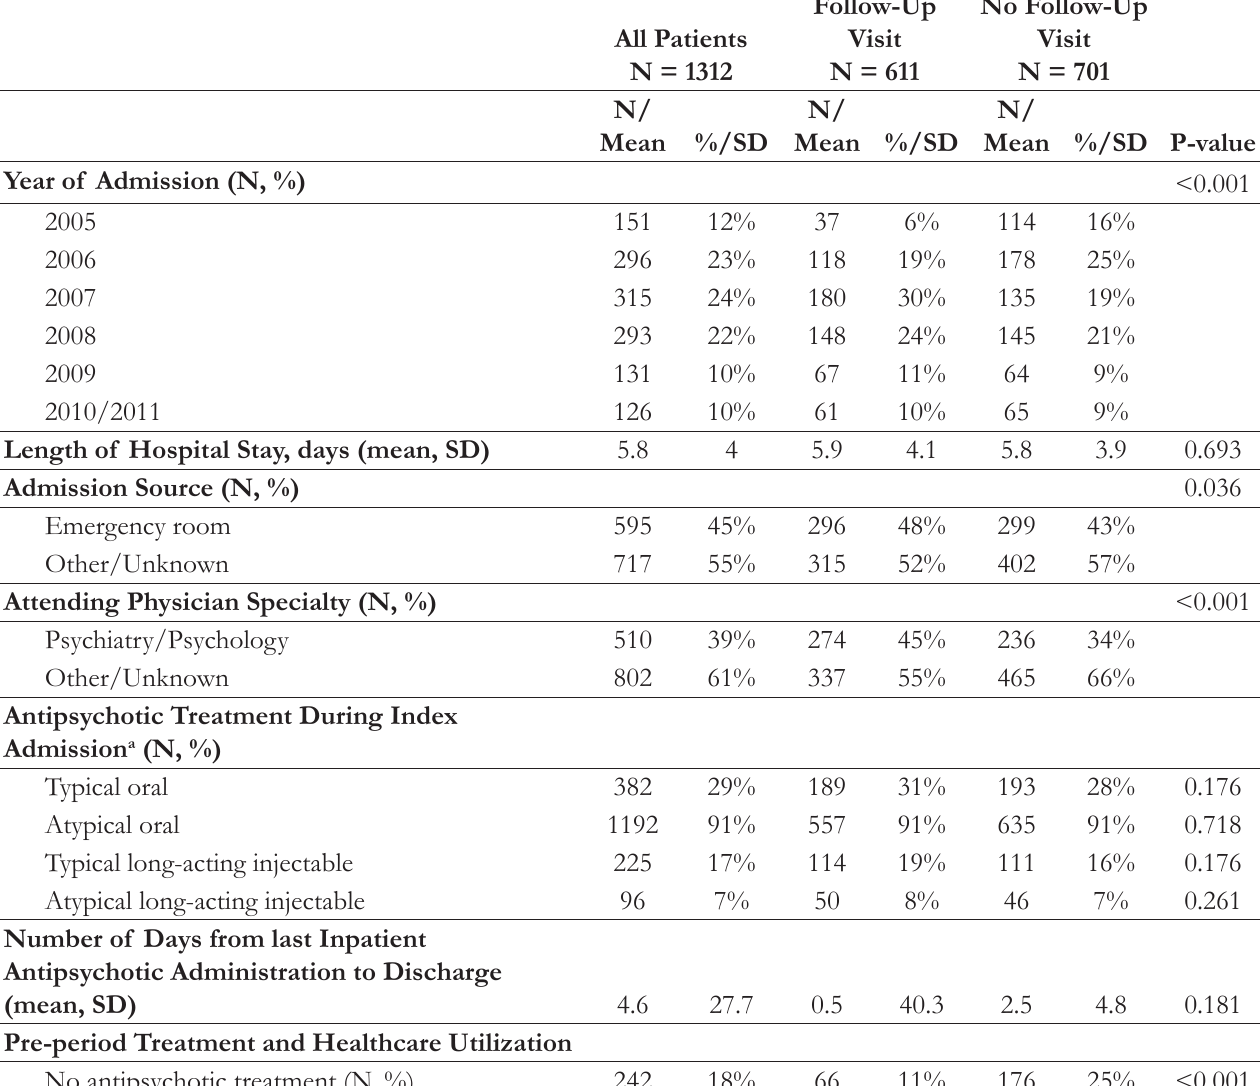
Table 2. Hospitalization and Treatment Characteristics